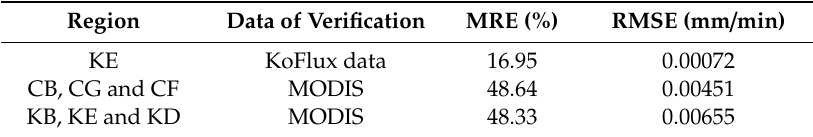
Table 5. Using Flux data and MODIS to verify the accuracy of simulated ET.